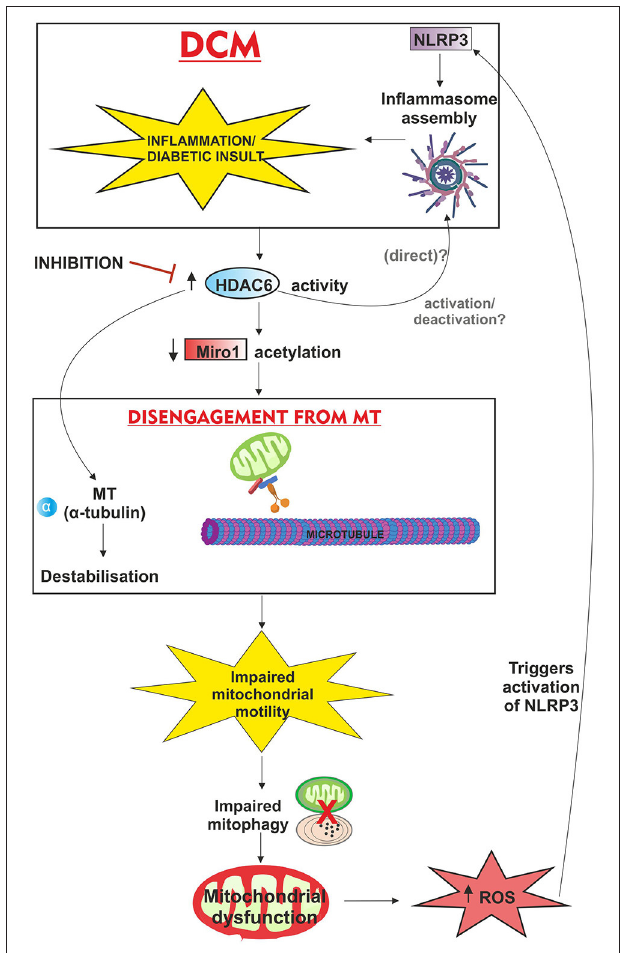
FIGURE 2 | Schematic overview of proposed mechanism of action of HDAC6 and associated deacetylation; linking mitochondrial motility, inflammation and the putative involvement of post-translational modifications in DCM. Inflammation/diabetic insult triggers HDAC6 activity which directly interacts with NLRP3 via ubiquitin binding domains (although it is unknown whether this activates/inactivates NLRP3 and inflammasome assembly in the heart). The combination of microtubule (alpha-tubulin) destabilisation and reduced acetylation (important for microtubule stability), contributes to disengagement of the mitochondria from the microtubule apparatus and halts mitochondrial movement. With mitochondrial motility linked to mitophagy, the removal of damaged mitochondria (potentially ROS producing) is impaired, leading to subsequent mitochondrial dysfunction, and oxidative stress further exacerbating inflammation via NLRP3. Inhibition of HDAC6 activity is also reported as cardioprotective.